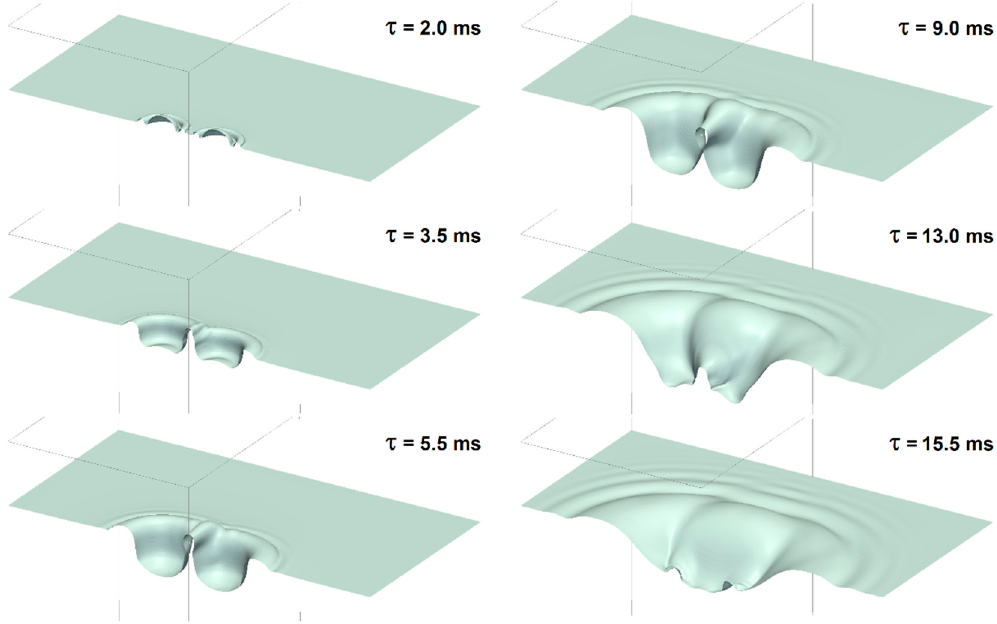
Figure 11. Rendering of some frames showing the crater evolution from the simulation of case B (w = 1.4 m/s), simulated with 12.35 Mcells.